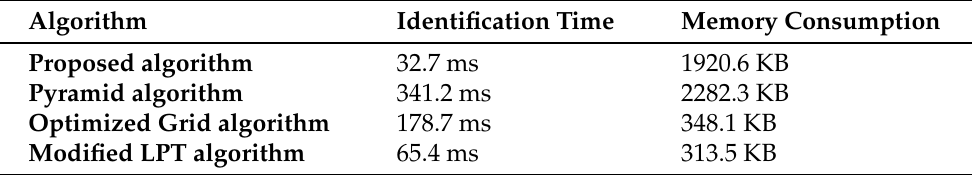
Table 2. The identification time and memory consumption of the three